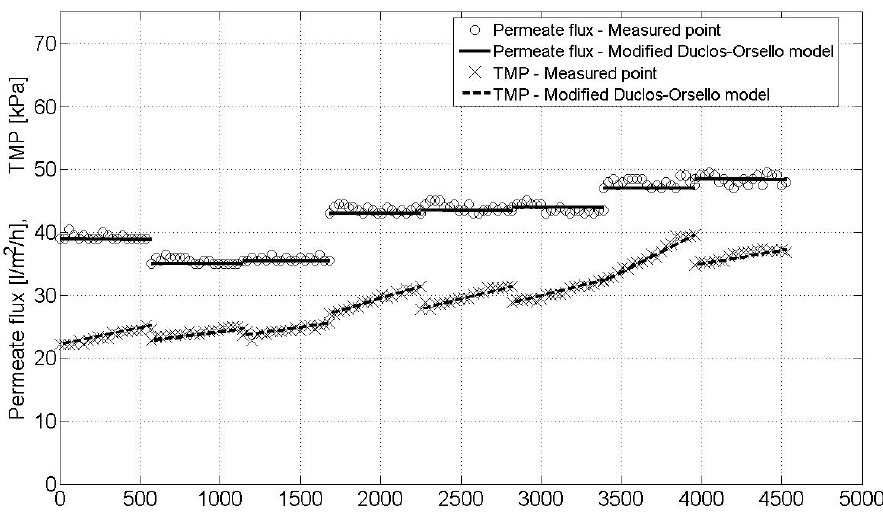
Figure 2. Modified phenomenological model—best model fit for 8 flux steps.